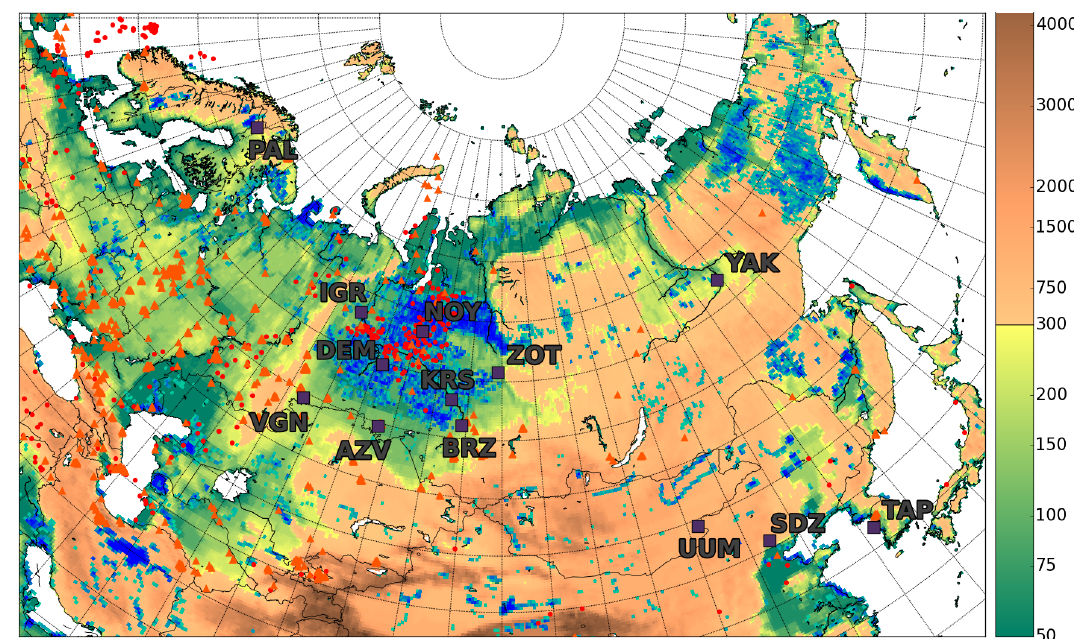
Figure 3. Topographic map of the domain of interest. The colour bar shows the altitude above sea level (from ETOPO1 database; Amante and Eakins, 2009). Red dots (resp. orange triangle) depict hotspots of CH 4 emissions (based on EDGAR v4.2 inventory; see Sect. 5.1) related to oil welling and refineries (resp. gas extraction and leaks during distribution in population centres). Purple squares highlight the observation site localization. Blueish shaded areas represent average inundated regions, wetlands and peatlands (from the Global Lakes and Wetlands Database; Lehner and Döll,